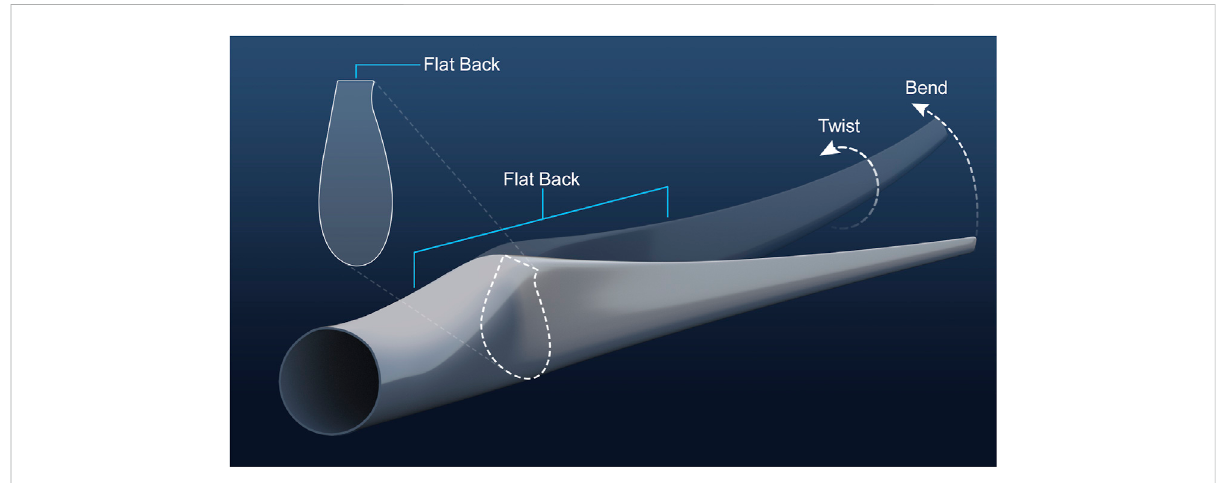
FIGURE 3 Digital rendering of a modern bend-twist fl at backed wind turbine blade. Cross sectional view of the fl at back is seen in the upper left corner.